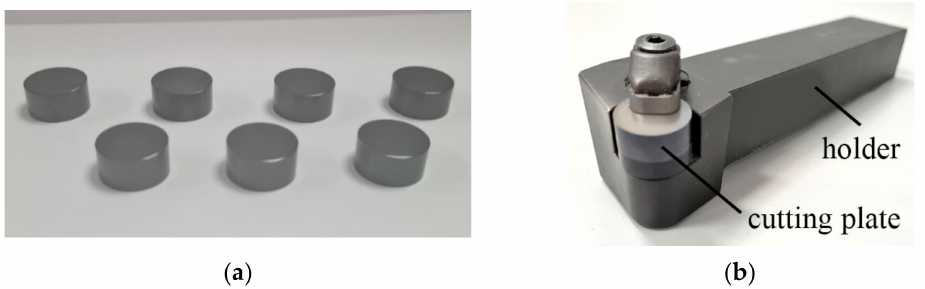
Figure 2. ( a ) Photograph of 19.05 mm-diameter and 7.9 mm-high ceramic cutting plates used in the